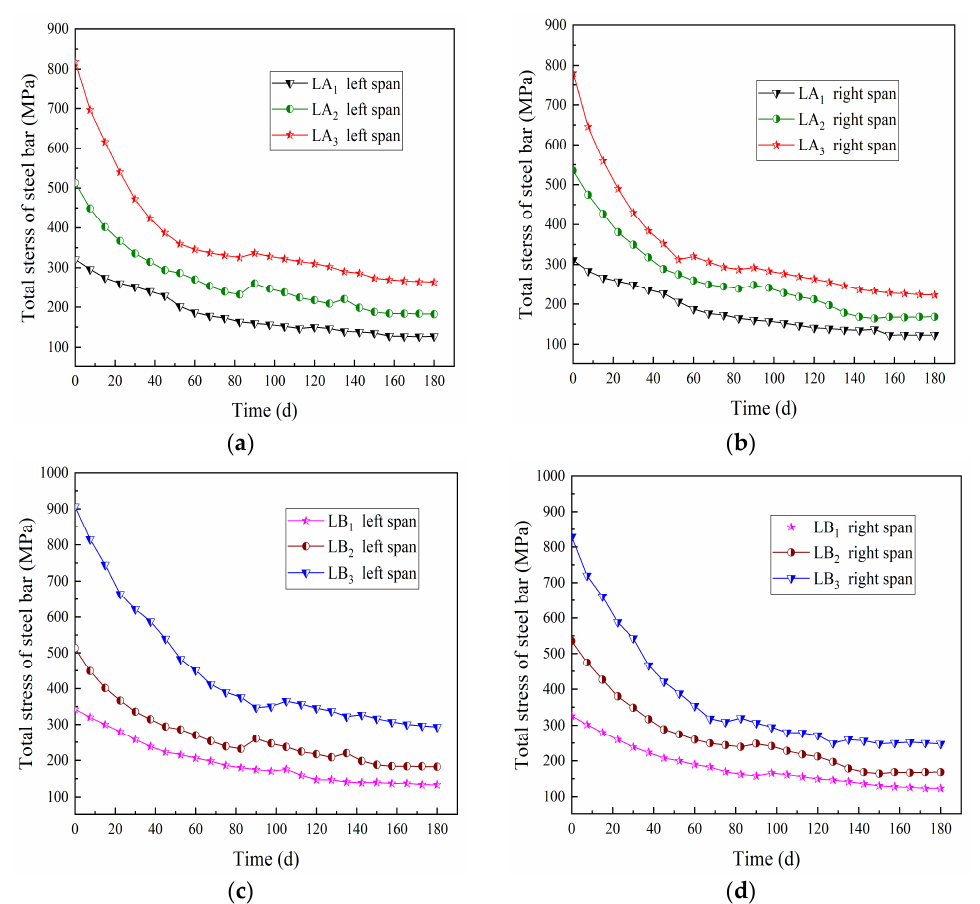
Figure 8. Time-varying curve of total stress of the steel wires. ( a ) Left span of group A (different steel wires quantities); ( b ) right span of group A (different steel wires quantities); ( c ) left span of group B (different prestress values); ( d ) right span of group B (different prestress values).